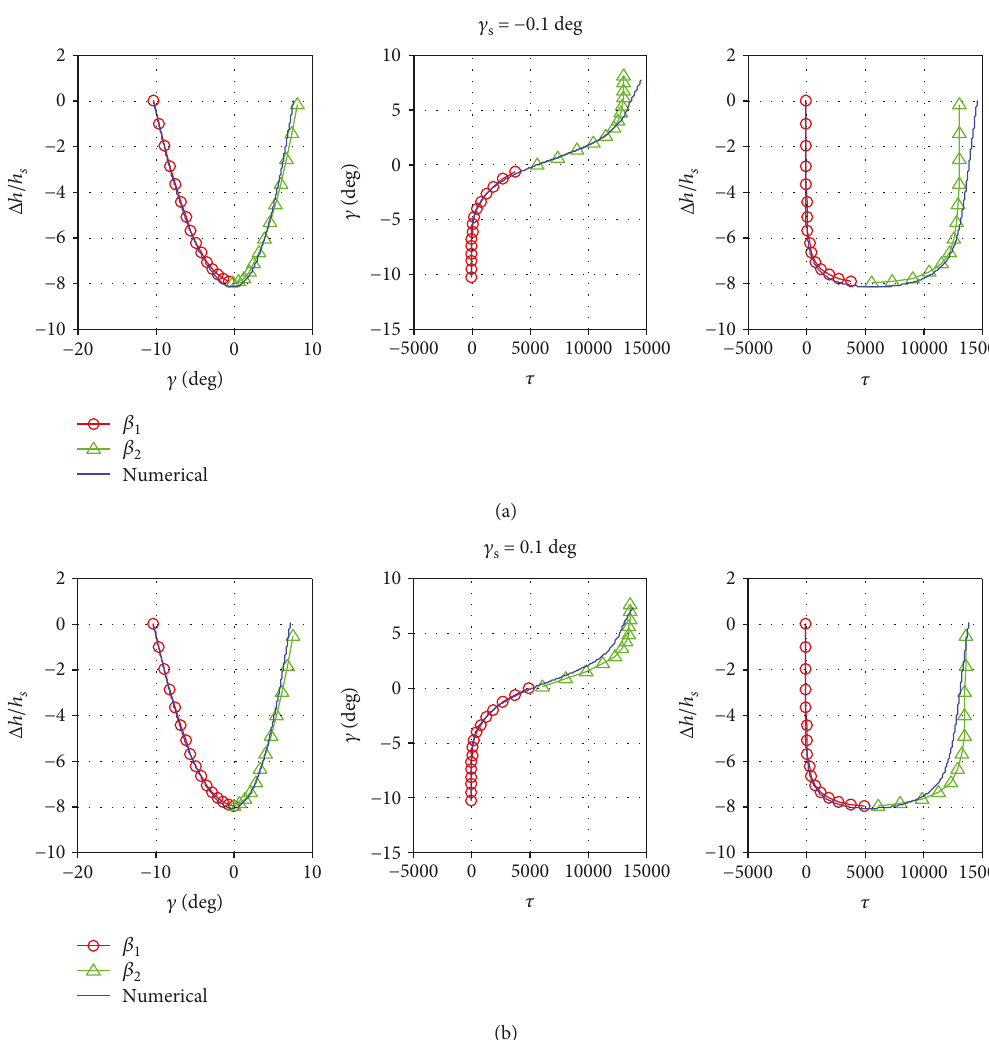
Figure 4: Analytical solution for single ballistic coe ffi cient